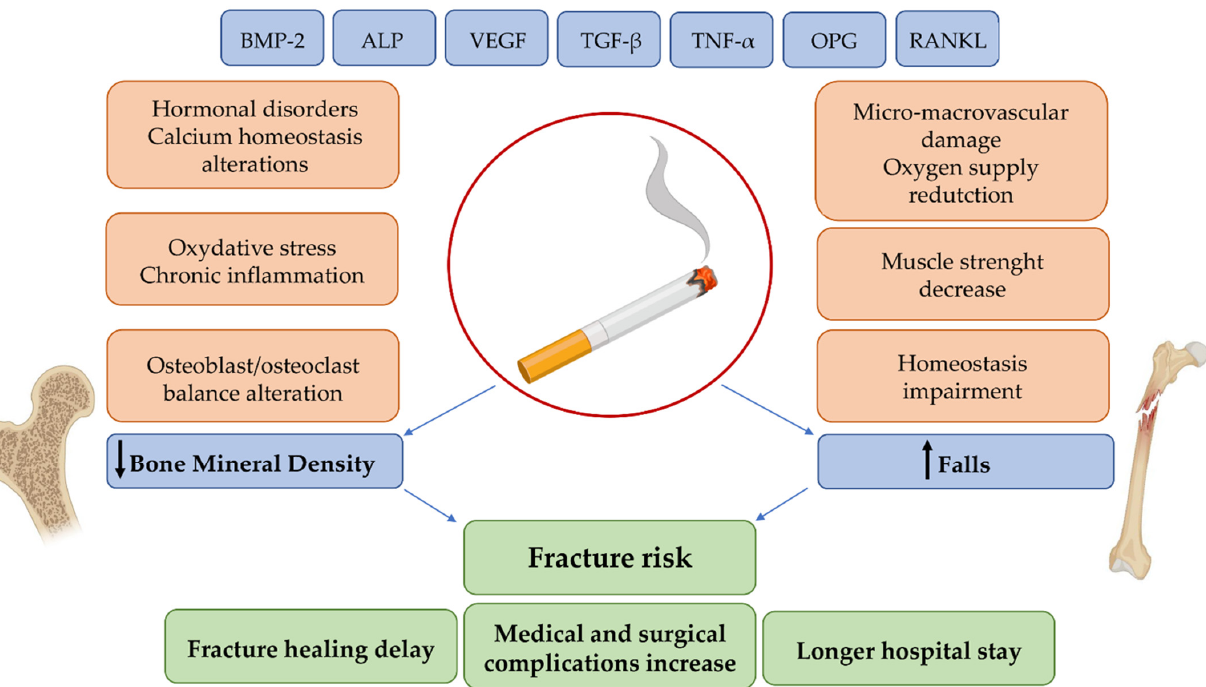
Figure 2. Schematic representation of the relationship between the biological effects and clinical consequences of smoking.